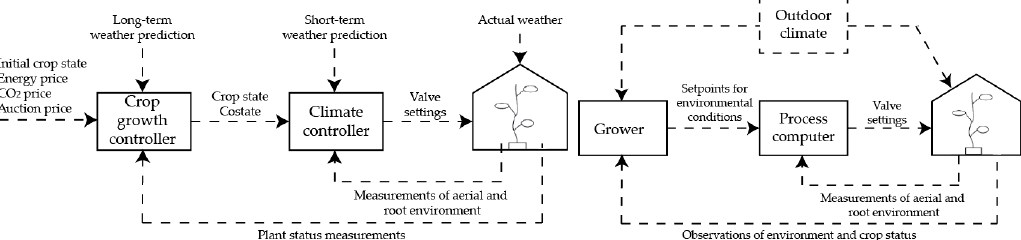
Figure 3. Crop planning module (CPM) and an interfacing block (IB) (adapted from [32]).